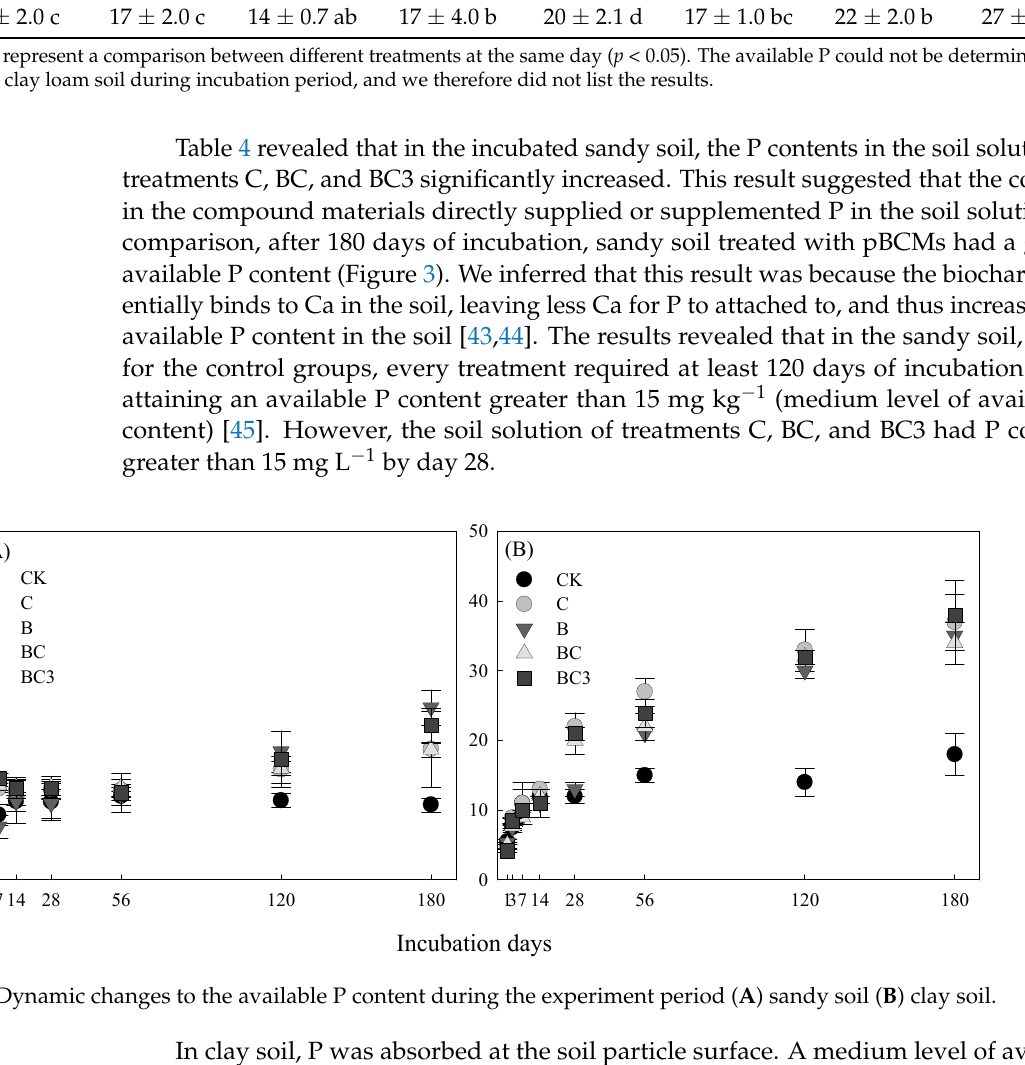
CK C B BC BC3 Figure 4. Dynamic changes in the exchangeable K content during the experiment ( A ) sandy soil ( B ) clay soil.